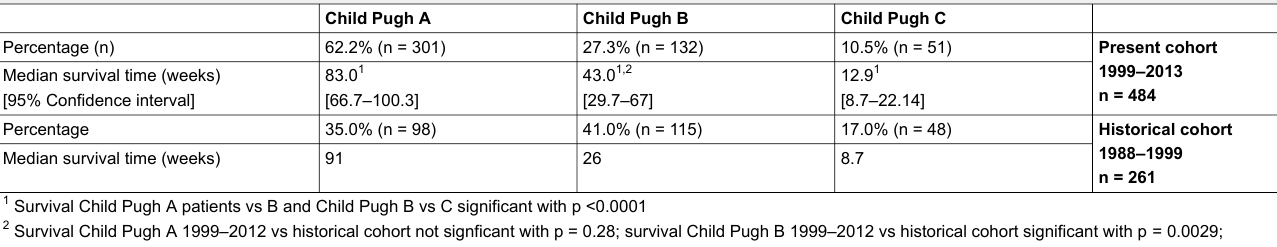
Kaplan-Meier curve for survival by BCLC score in patients with hepatocellular cancer (n = 6, 160, 94, 169 and 55 for BCLC 0, A, B, C and D, respectively; p <0.001 for B vs A, C vs B and D. C). BCLC = Barcelona clinic liver cancer score Table 2: Child Pugh classification: distribution and survival time in the present and in the historical cohort.